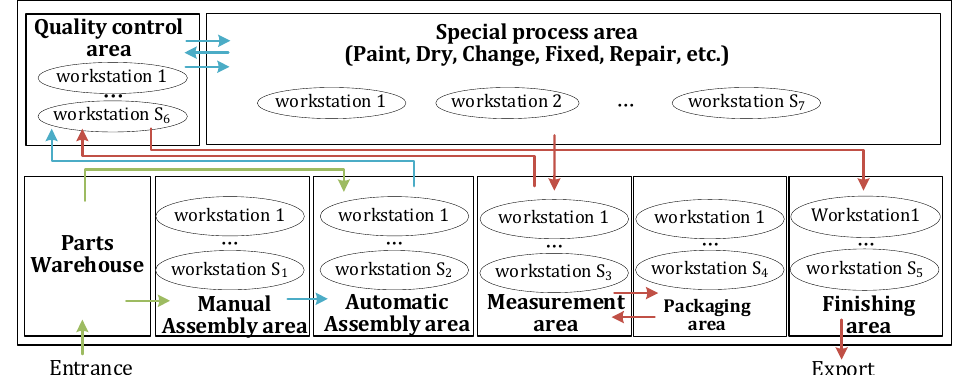
Figure 2. The layout of general assembly workshop.